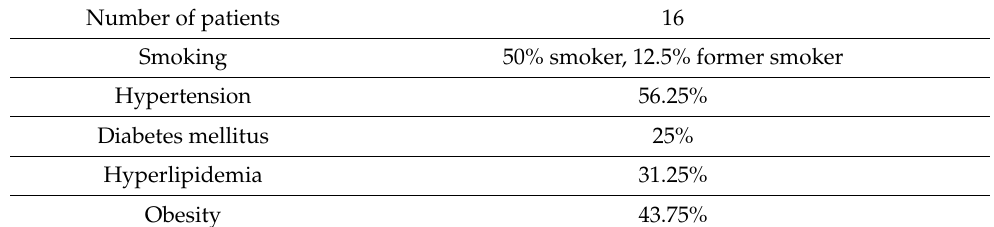
Table 1. Main demographic and clinical characteristics of the patients.